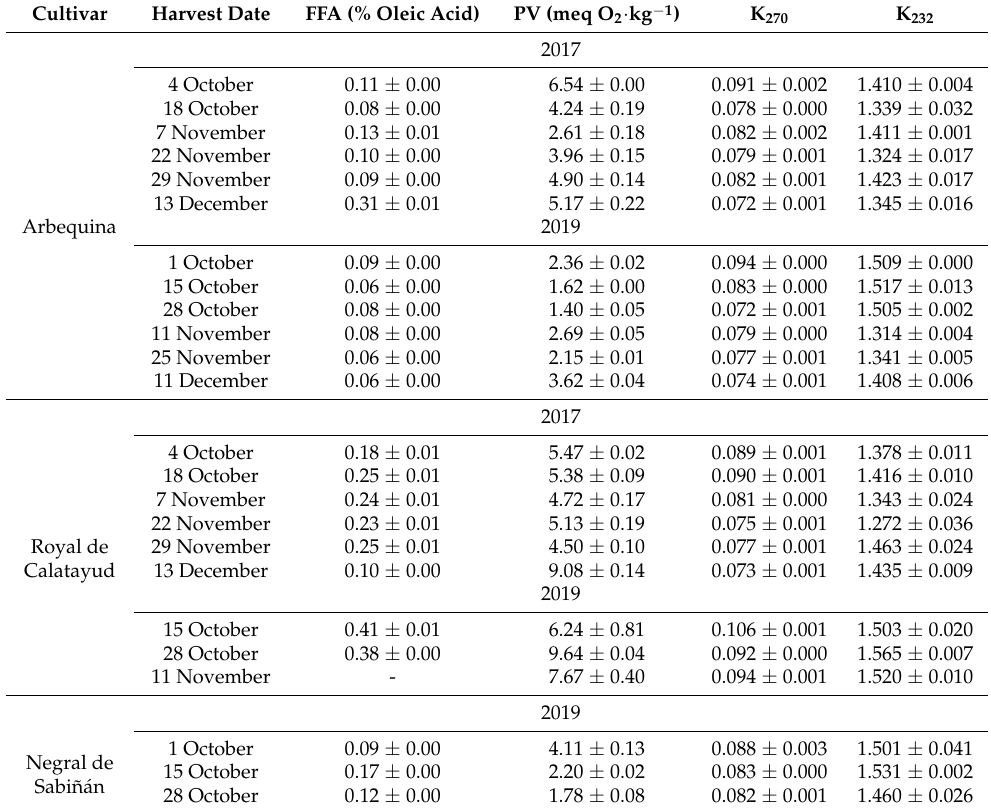
Values are mean ± standard deviation ( n = 2). FFA = free fatty acids; PV = peroxide value. Limits established by the current European legislation for extra virgin olive oils: FFA ≤ 0.80% oleic acid; PV ≤ 20.0 meq O 2 · kg − 1 ; K 270 ≤ 0.22; K 232 ≤